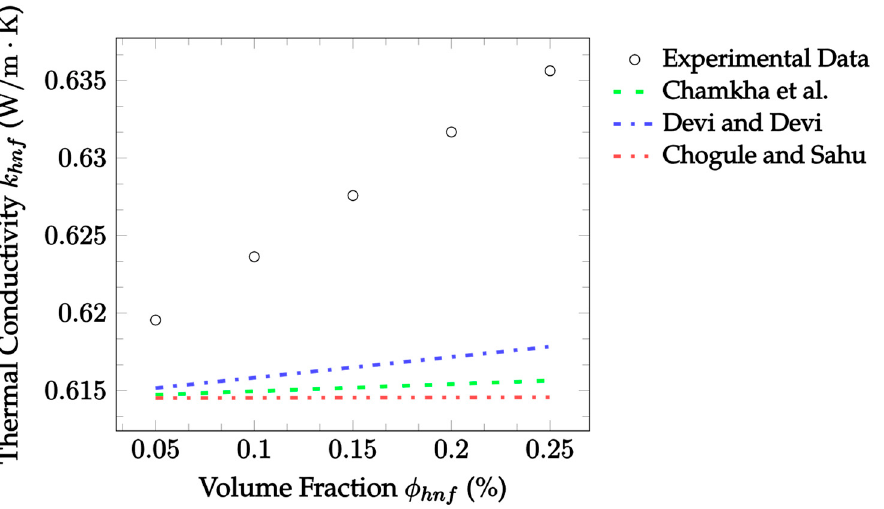
Figure 13. Experimental findings for 50:50 TiO 2 –CaCO 3 /Water hybrid nanofluid compared with the- oretical predictions by general hybrid nanofluid models: Experimental Data [87], Chamkha et al. [37], Devi and Devi [38], Chougule and Sahu [39].